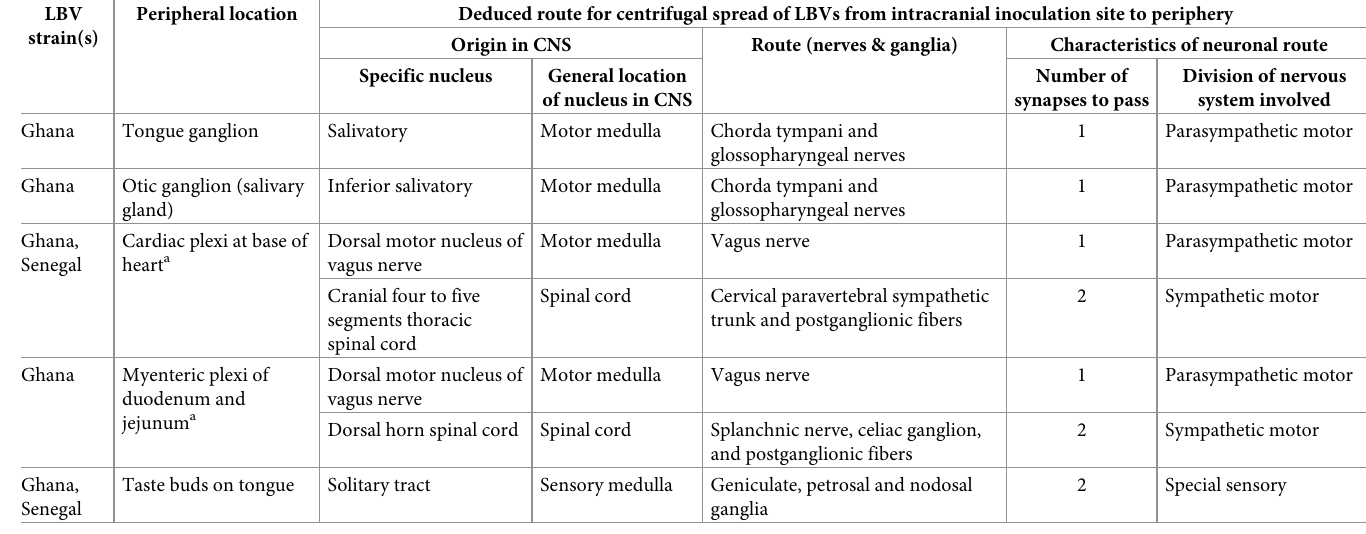
Table 4. Neuronal routes different Lagos bat viruses travelled from the intracranial inoculation site to the